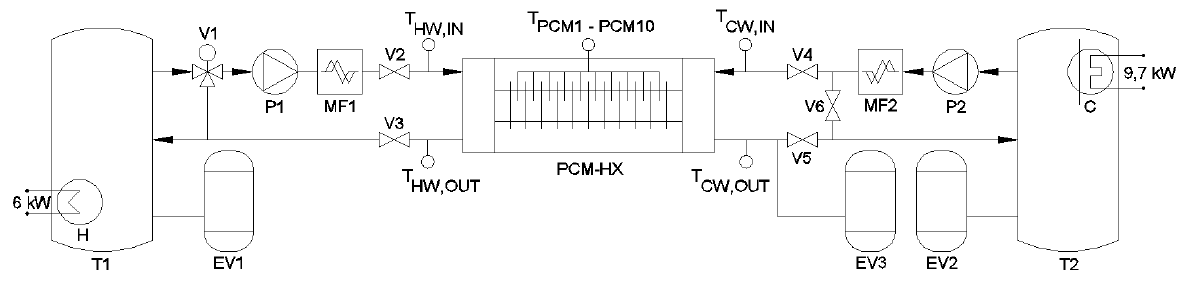
Figure 1. Schematic representation of the experimental setup (T PCM , T HW and T CW —temperature sensors; T1, T2—tanks for hot and cold water storage; EV1, EV2, EV3—expansion vessels; H—hot water heater, C—cold water cooler; V1—mixing valve with electronic constant temperature controller; V2–V6—manual valves; MF1, MF2—flowmeters; P1, P2—circulating pumps).